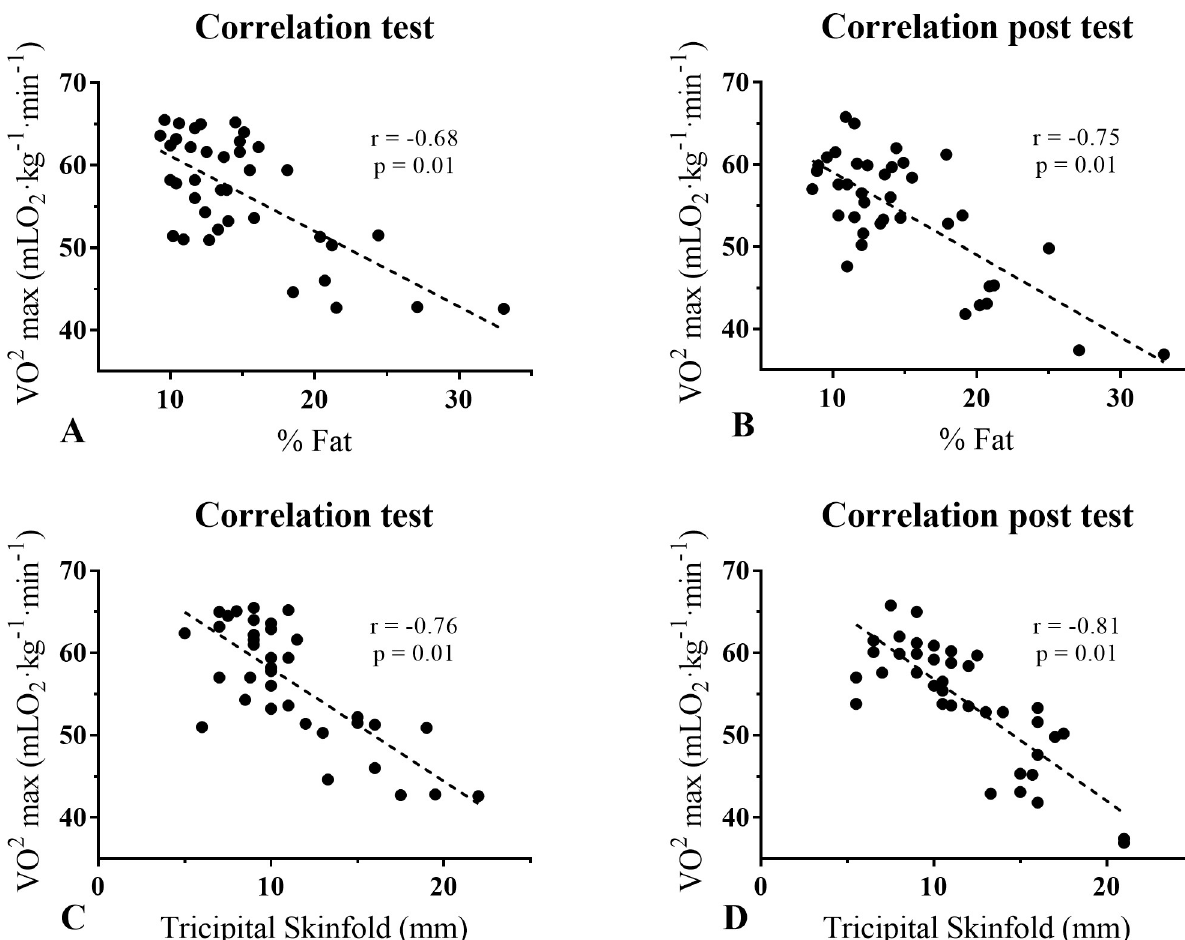
Fig 4. Correlation between VO 2 max and anthropometric parameters before and after 12 weeks without mandatory physical training.